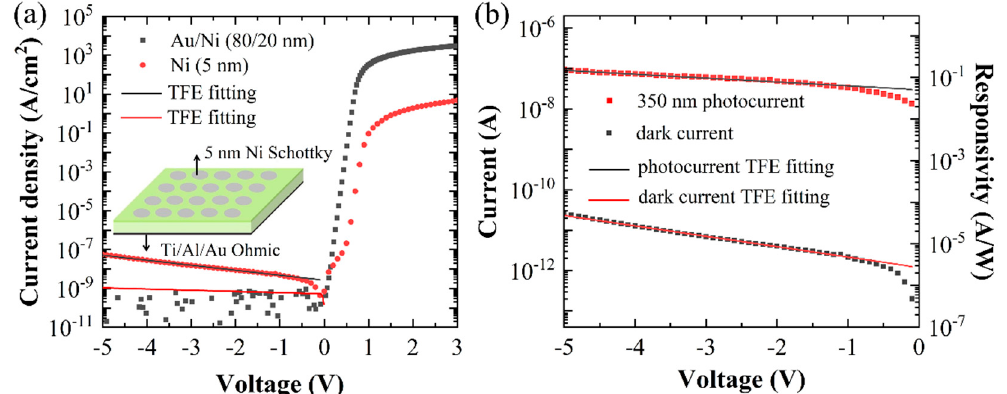
Figure 1. ( a ) I-V characteristics for device-A (5-nm-thick Ni) and device-B (Ni (20 nm) / Au (80 nm)). The reverse I-V curves can be well seen by the TFE model. The inset depicts the schematic structure of device-A. ( b ) The reverse dark current and photo-current under 350 nm illumination for device-A. The fitting curves governed by TFE are shown.